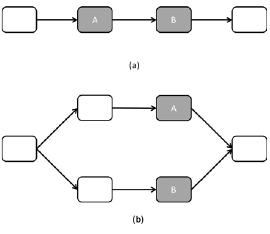
Figure 9: (a) Computation steps are executed in sequence in sequential workflow. (b) Parallel steps can be offloaded and executed